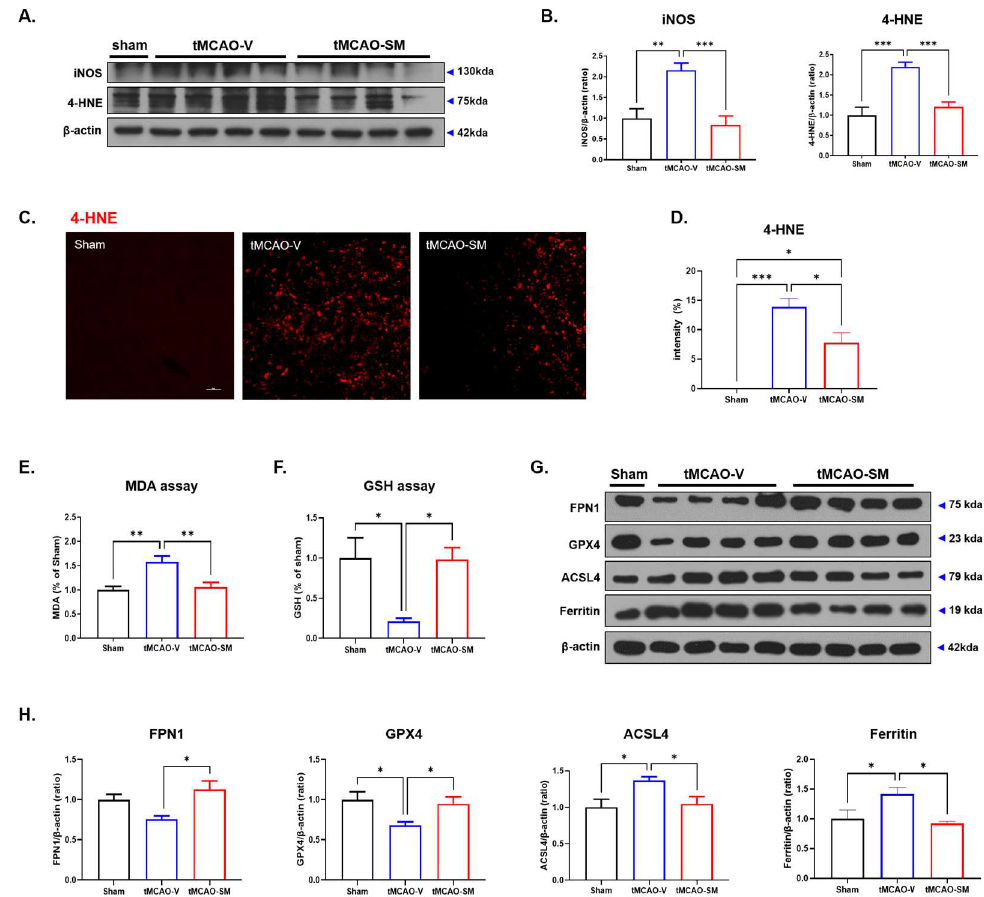
Figure 4. SM alleviated oxidative stress and ferroptosis in tMCAO mouse brain. ( A ) Representative Western blots showing the expression of iNOS and 4-HNE proteins in penumbra region of tMCAO mouse brain. ( B ) Protein level quantification of iNOS and 4-HNE in penumbra region of tMCAO mouse brain. (Sham, n = 4; tMCAO-V, n = 6; tMCAO-SM, n = 6). ( C ) Representative images of 4-HNE staining in penumbra region of tMCAO mouse brain. ( D ) 4-HNE quantification of intensity in tMCAO mice (Sham, n = 3; tMCAO-V, n = 6; tMCAO-SM, n = 6). ( E ) Quantification of MDA level using MDA assay kit ( F ) Quantification of GSH level using GSH assay kit. ( G ) Representative Western blots showing the expression of FPN1, GPX4, ACSL4 and Ferritin proteins. ( H ) Quantification of Western blot for FPN1, GPX4, ACSL4, and Ferritin. (Sham, n = 4; tMCAO-V, n = 6; tMCAO-SM, n = 6). Values are expressed by the mean ± SEM. Statistical analysis between the three